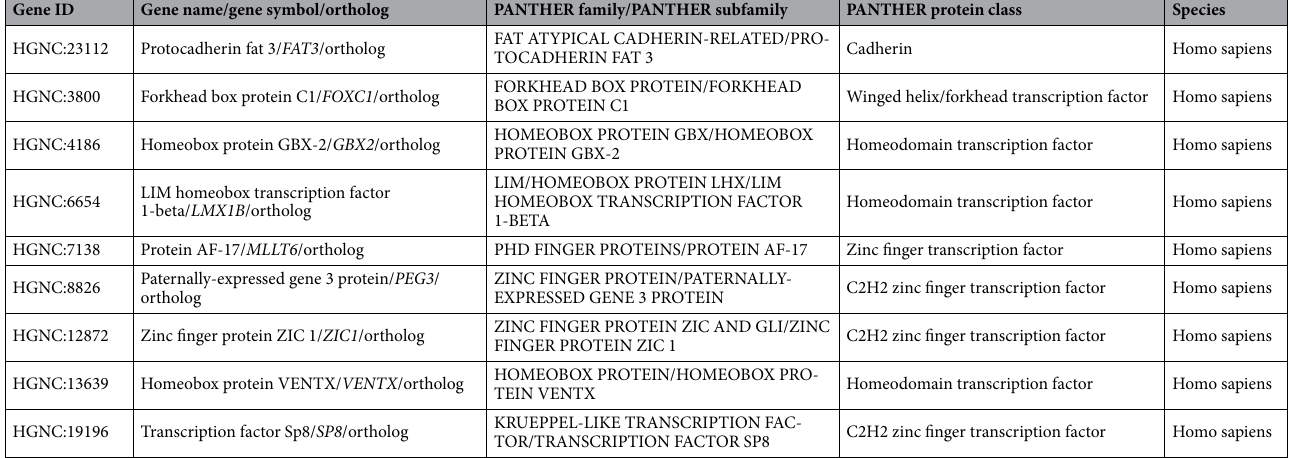
Table 1. Nine genes involved in transcription regulation (genes information are based on PANTHER classification system).